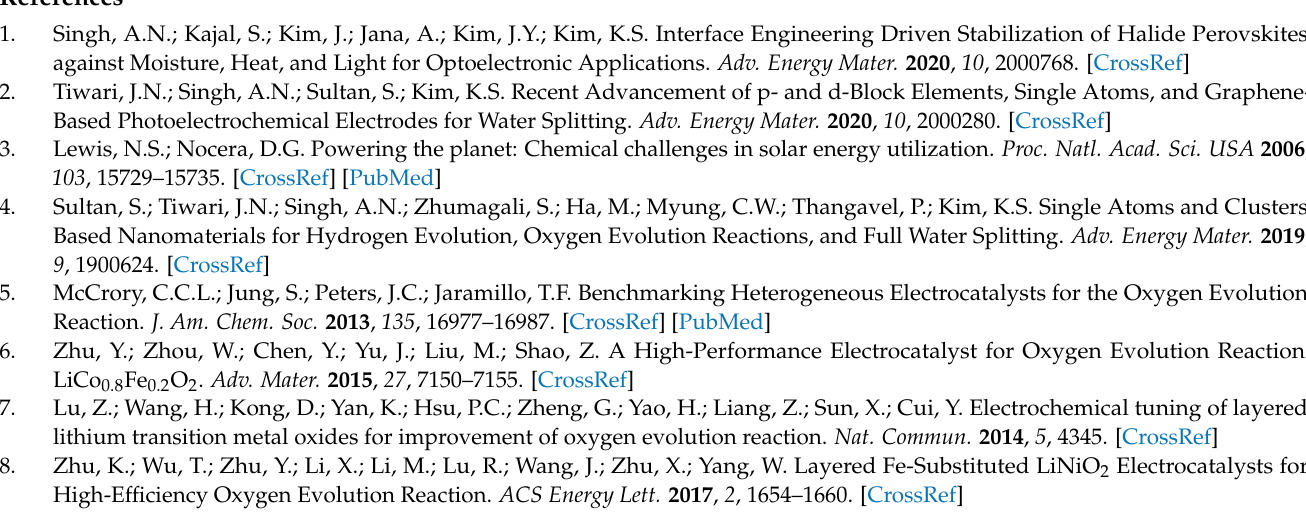
Figure S6: Equivalent circuit; Figure S7: HRTEM image after long-term stability (scale bar 2 nm). The lattice fringe distance after long-term stability remains almost same to that of Figure 2b; Figure S8: Calibration of the Hg/HgO reference electrode. For all measurements, Hg/HgO was used as the reference electrode. The Hg/HgO calibration with respect to the reversible hydrogen electrode (RHE) was performed in the high purity H 2 saturated electrolyte with Pt wire as the working electrode. LSV was run at a rate of 1 mV s -1 , and potential at zero mA current was taken to be the thermodynamic potential for hydrogen evolution reactions. So, in 1M KOH, E(RHE) = E(Hg/HgO) + 0.905; Table S1: The ICP-OES results of synthesized powders. The data shows the number of atoms per mole of material. The ICP-OES data were taken several times and the best data obtained are presented here with a round off to the nearest two decimal places. The data in parentheses () denotes the theoretical values; Table S2: A comparative chart for overpotential ( η ) of cathode materials used as OER electrocatalyst; S1. Effect of Na-doping on binding energy; S2. Structural